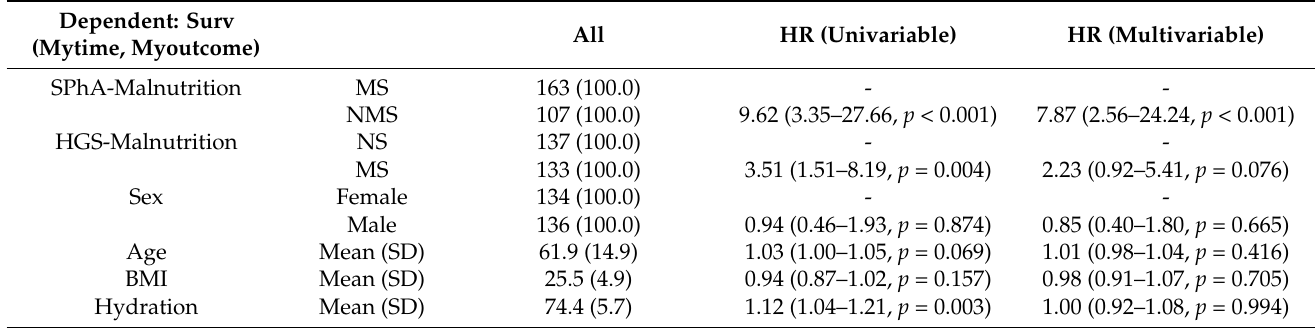
Table 4. Model multivariate analysis to evaluate the utility of the bioelectrical parameters as prognos- tic indicators of mortality in admitted patients.